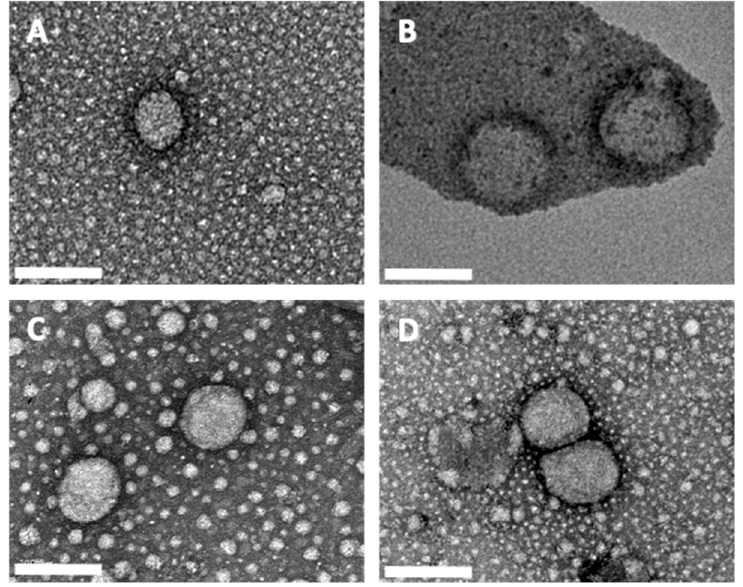
Figure 1. TEM images of unloaded NLCs ( A ); naringenin-loaded NLCs ( B ); NDGA-loaded NLCs ( C ), and kaempferol-loaded NLCs ( D ). Scale bars correspond to 200 nm.